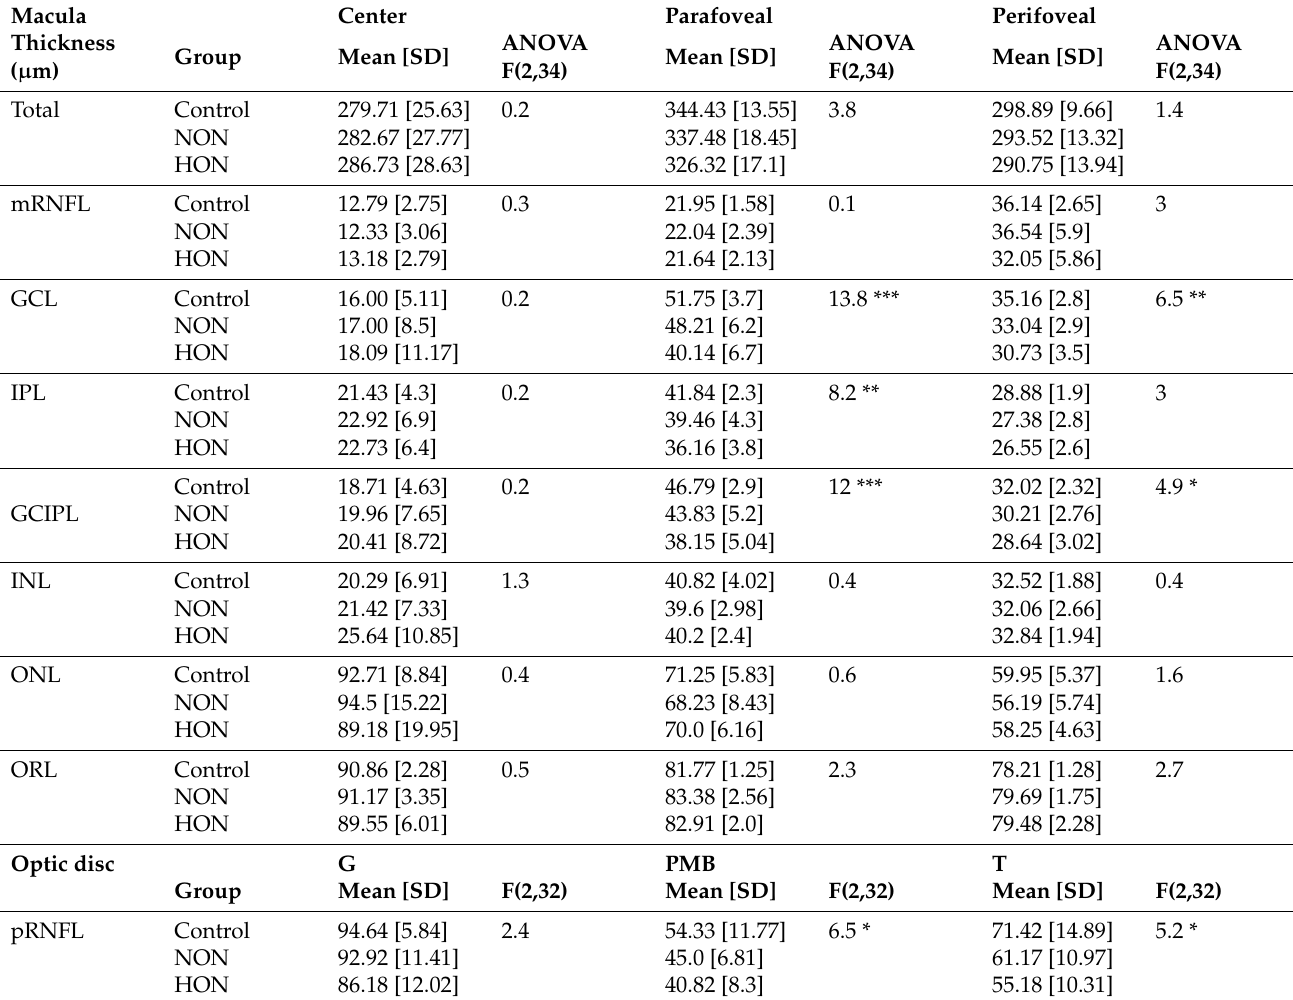
NON = multiple sclerosis without a history of optic neuritis; HON = multiple sclerosis with a history of optic neuritis; peripapillary retinal nerve fiber layer thickness: G = global average thickness, T = temporal, PMB = papillomacular bundle; mRNFL = macular retinal